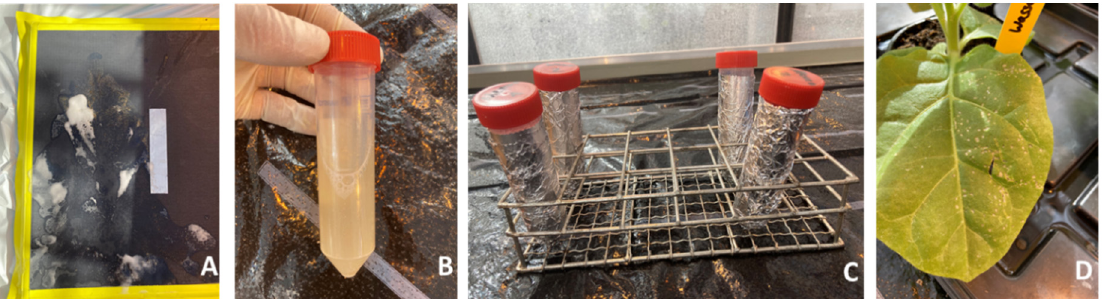
Figure 2. Illustration of disinfection performance inside the disinfection mat. ( A ): disinfection mat with layer of potentially infectious dirt derived from scraping off ToBRFV-contaminated germ carriers, ( B ): dirt mixed with liquid from the inside of the disinfection mat, ( C ): incubation of that mixture in the dark, ( D ): necrotic local lesions after the inoculation of that mixture on test plants (here water control).